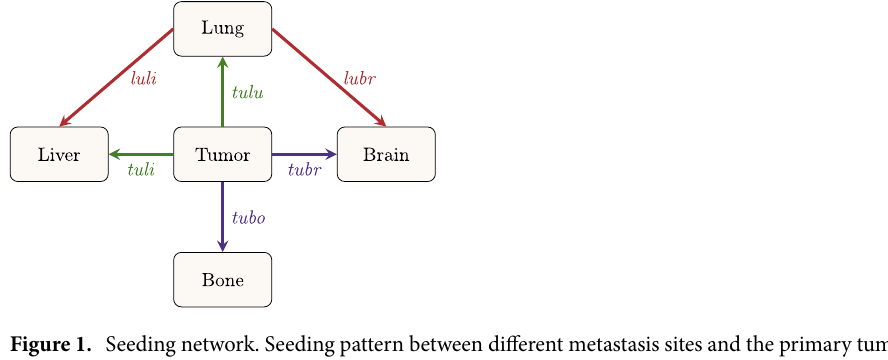
Figure 1. Seeding network. Seeding pattern between different metastasis sites and the primary tumor. Dissemination rate from tumor to bone represented by parameter “ tubo ”, tumor to lung by “ tulu ”, tumor to liver by “ tuli ”, tumor to brain by “ tubr ”, lung to liver by “ luli ” and lung to brain represented by “ lubr ”. Green arrows indicate primarily lymphatic spread, blue arrows venous spread and red arrows hematogenous